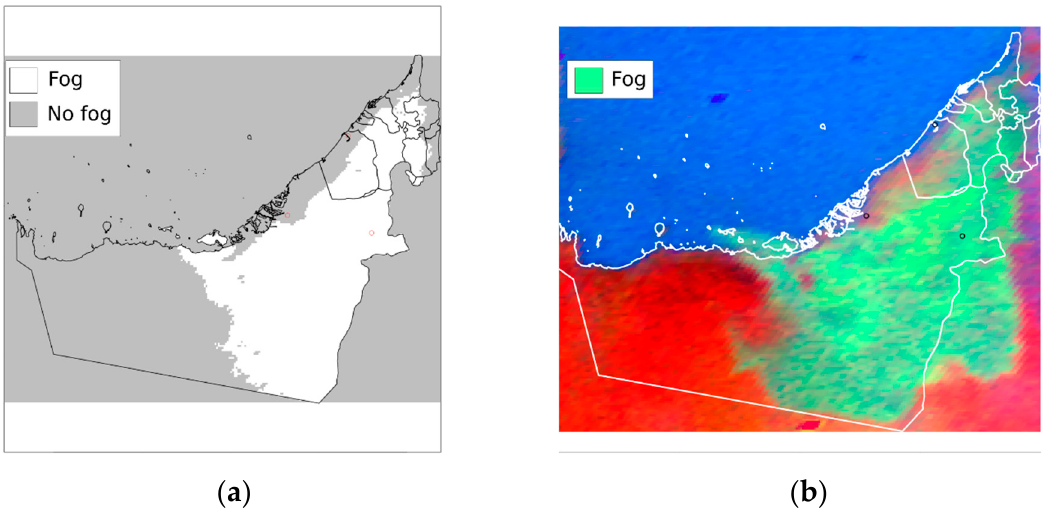
Figure 7. ( a ) Example of ems(3.9)-low cloud fog classification in comparison with ( b ) the EUMETSAT Figure 7. a ) Example of ems(3.9)-low cloud fog classification in comparison with b ) the EUMETSAT night microphysical product [30] for 2018-01-15 0300 local night microphysical product [30] for 2018-01-15 0300 local time.